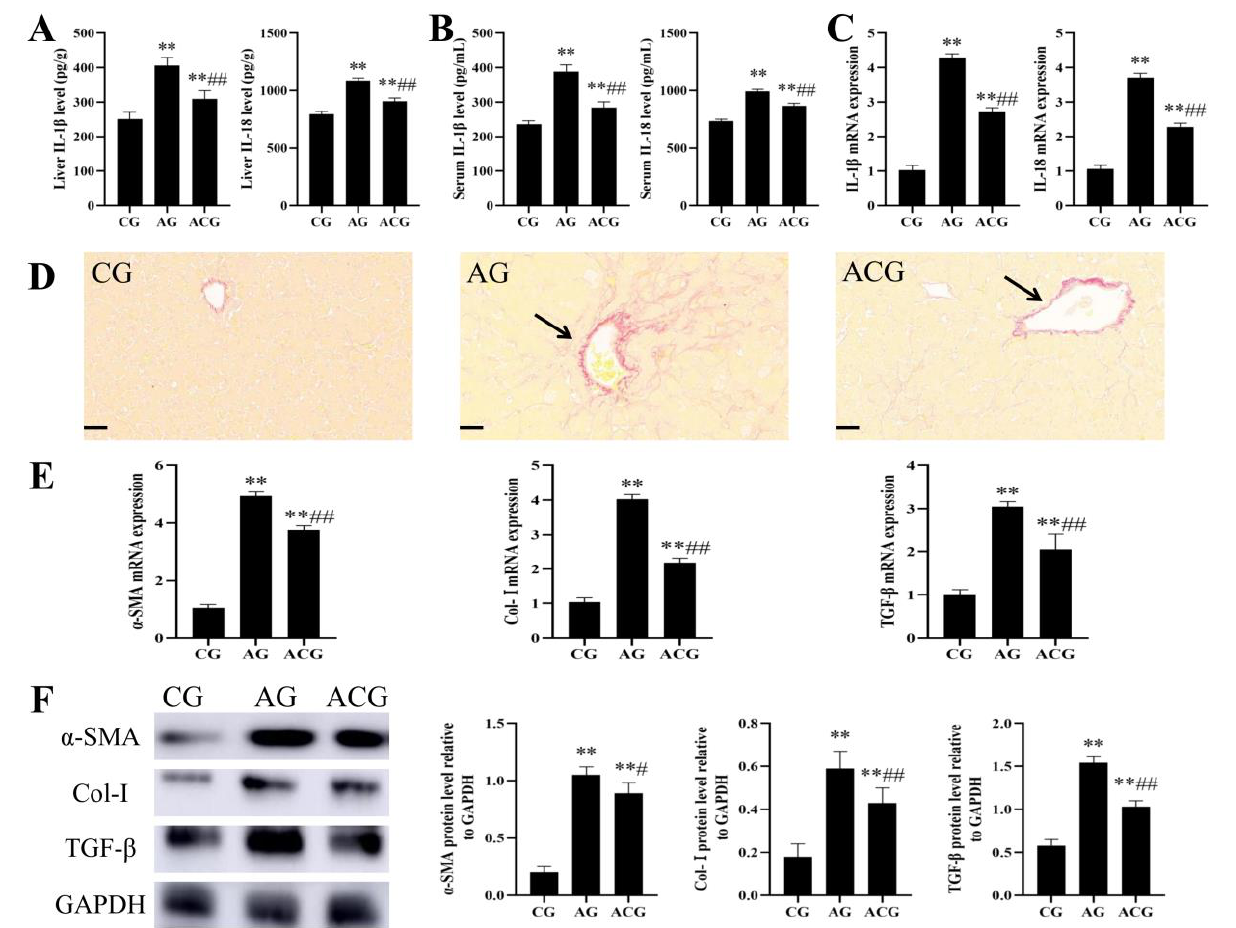
Figure 7. Curcumin alleviated liver fibrosis in ducks caused by AFB 1 . ( A ) Liver IL- 1β and IL-18 levels ( n = 6). ( B ) Serum IL- 1β and IL-18 levels ( n = 6). ( C ) mRNA expressions of IL- 1β and IL-18 ( n = 6). ( D ) Representative images of sirius red staining of duck livers (black arrow: fibrotic lesions). ( E ) mRNA expressions of α -SMA, Col- Ⅰ , and TGF- β ( n = 6). ( F ) Western blot analysis of the α -SMA, Col- Ⅰ , and TGF- β protein levels ( n = 3). ** p < 0.01 vs. the CG. # p < 0.05 and ## p < 0.01 vs. the AG.